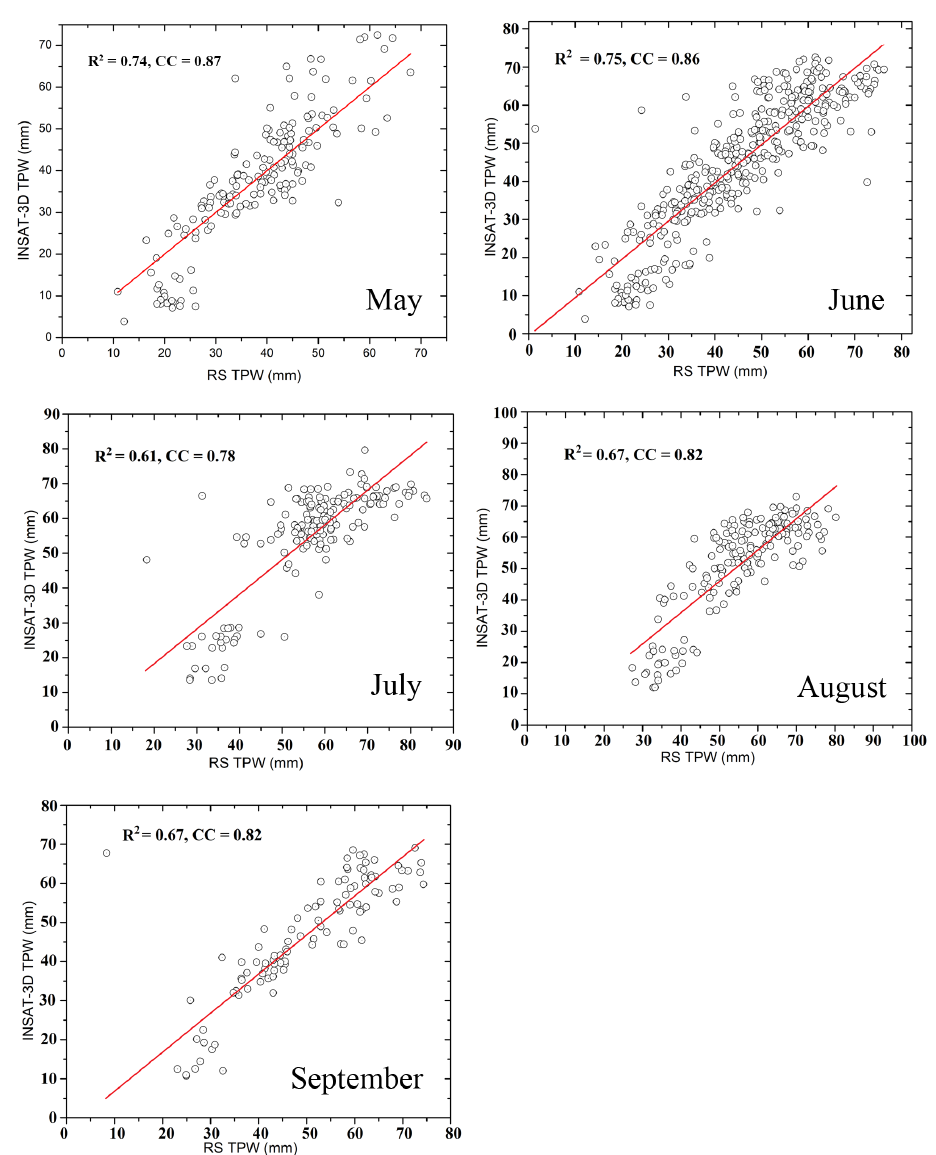
Figure 4. Comparison of INSAT-3D-derived TPW with RS-observed TPW for May, June, July, August, and September